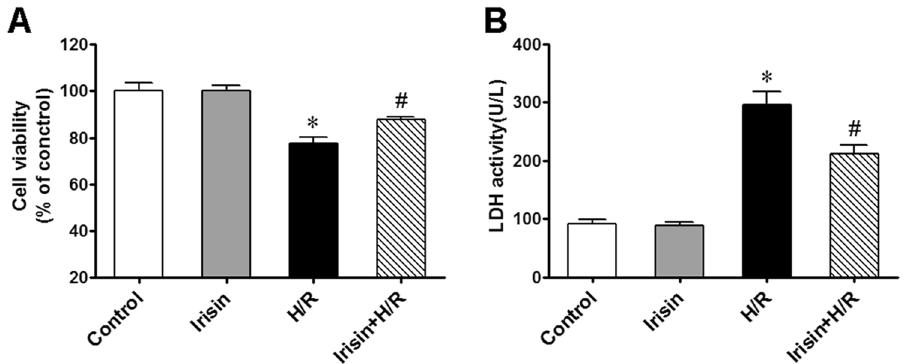
Figure 1. Irisin attenuated H/R induced cell injury. Cell viability was determined by CCK-8 kit, pretreated with irisin(100 ng/ml) significantly alleviated cell viability decrease induced by H/R exposure ( A ). Irisin